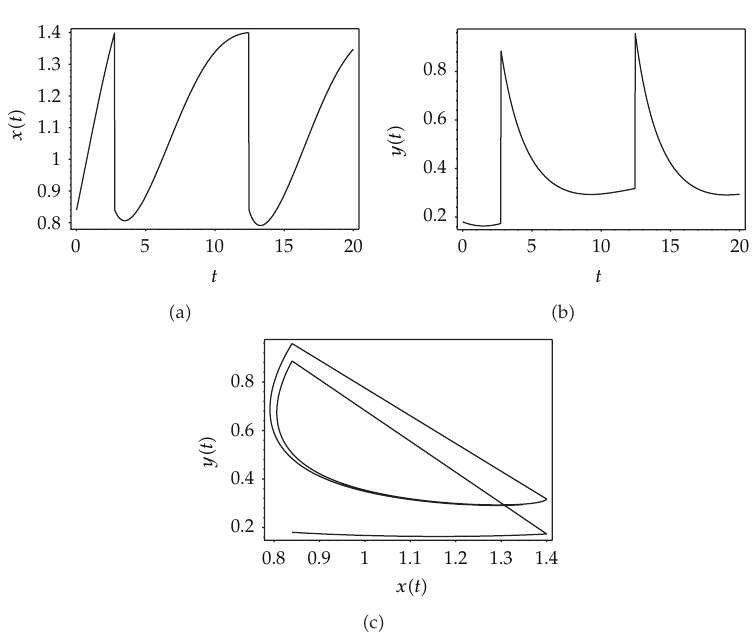
Figure 9: Time series and portrait phase of system (cid:6) 1.3 (cid:7) with p (cid:8) 0 . 4, q (cid:8) 0 . 5, x 0 (cid:8) 0 . 84, y 0 (cid:8) 0 . 18, and h (cid:8) 1 . 4 > x ∗